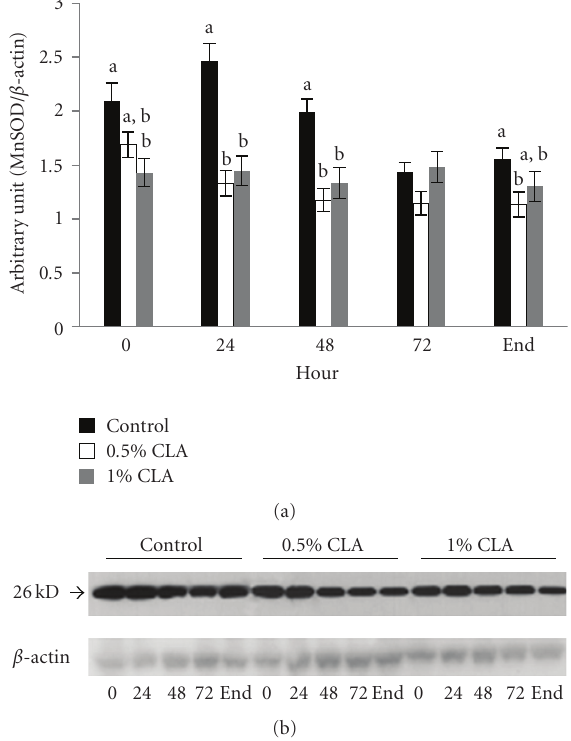
Figure 7: CuZnSOD protein expression in cutaneous wounds of mice fed diets containing 0 (control), 0.5%, or 1% CLA for 2 weeks. (a) Quantified CuZnSOD protein expression level determined by densitometry. Values are mean ± SEM; N = 4 to 6 in each group. Means at a time with a di ff erent letter are significantly di ff erent, P < . 05. (b) 0; 0hr, 24; 24hr, 48; 48hr, 72; 72hr after wounding, end (wound is completely closed).